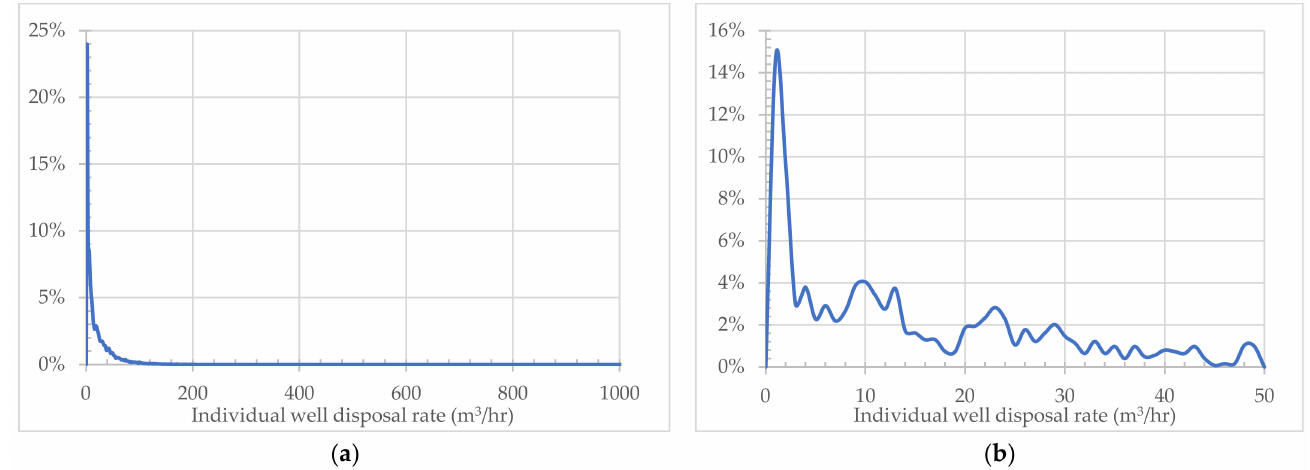
Figure A13. Historical per-well water injection rate ( X -axis) frequency ( Y -axis) distributions (January 1962–December 2023) in ( a ) the McMurray Formation; ( b ) the Cadomin Formation.